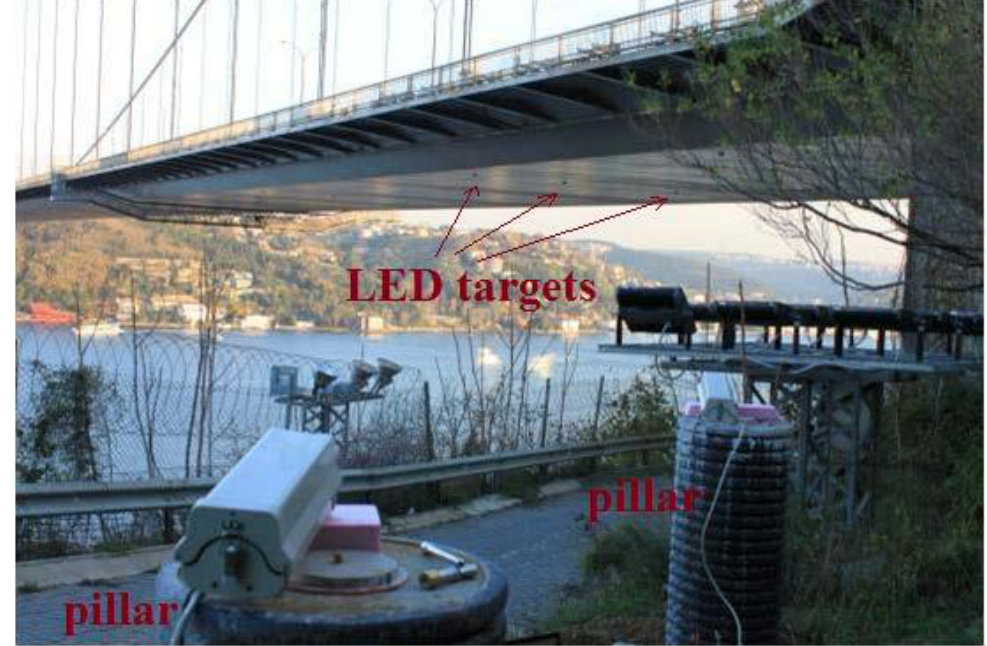
Figure 4. The two of the total four